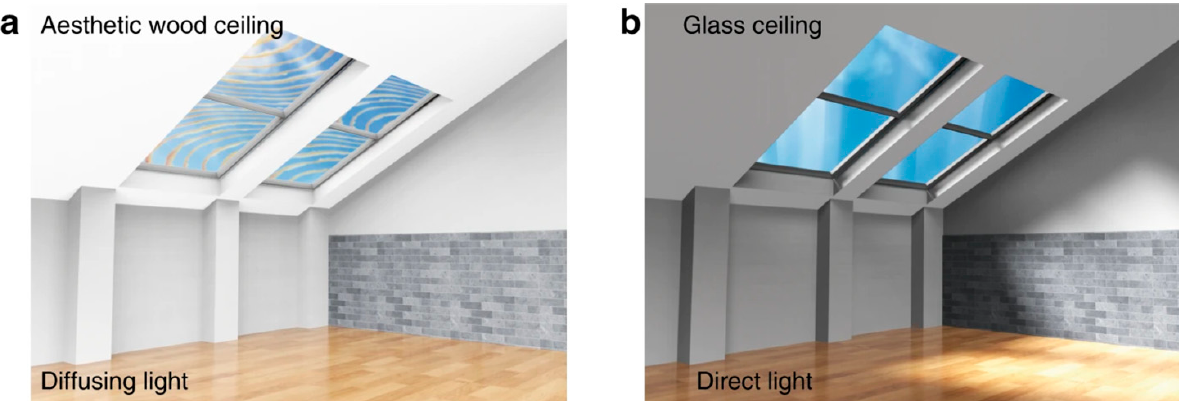
Figure 3. The schematic scene shows the light distribution and aesthetic appeal inside a building via applying ( a ) the aesthetic wood ceiling comparing with ( b ) the glass ceiling (Adapted from [50] ).